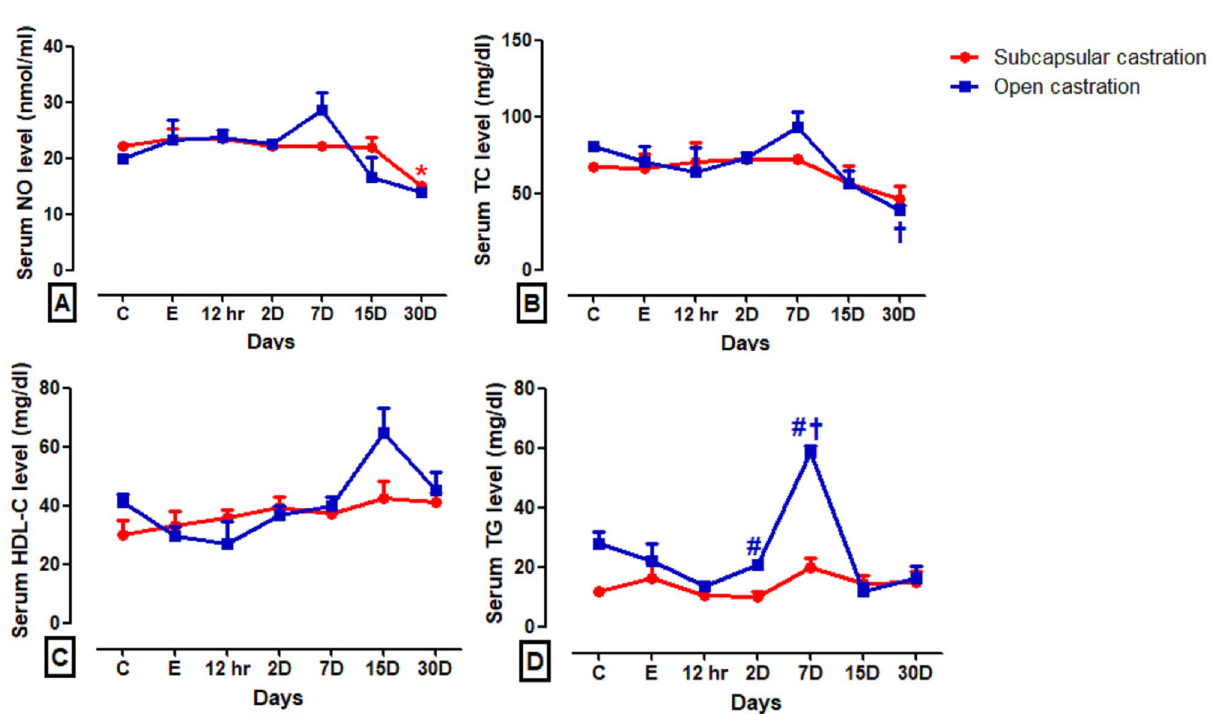
Figure 6. Serum concentrations of NO ( A ), TC ( B ), HDL-C ( C ), and TG ( D ) in the subcapsular (SC) and open (OC) castration groups. # Indicates significant difference between different groups, *Indicate significant difference at different time intervals within the SC, † Indicate significant difference at different time intervals within the